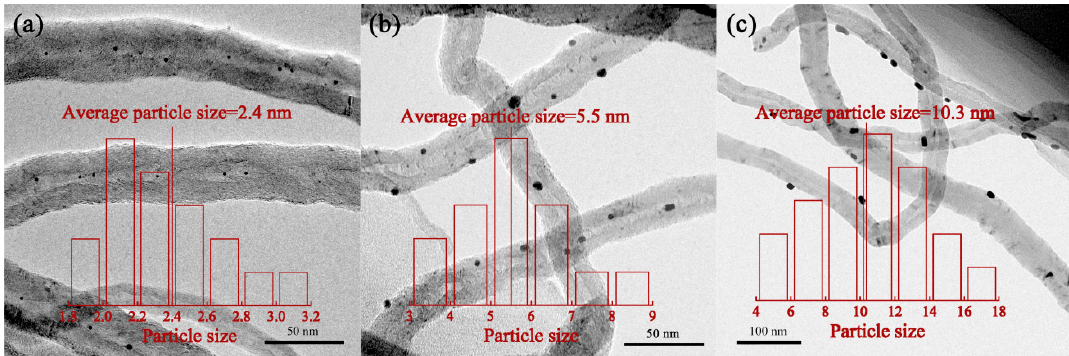
Figure 1. Transmission electron microscopy (TEM) images and particle size distribution of ( a ) Pt nanoparticles inside carbon nanotubes (CNTs) (Pt–in/CNTs); ( b ) Pt nanoparticles prepared via incipient wetness impregnation (Pt–imp/CNTs); ( c ) Pt nanoparticles outside CNTs (Pt–out/CNTs).